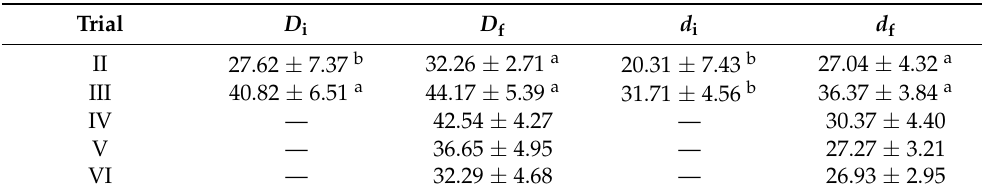
Table 2. Mean ( ± SD) size ( µ m) of larger ( D ) and smaller diameters ( d ) of oocytes from yellow clam ( Amarilladesma mactroides ) at the beginning and the end of the 14-day conditioning period in trials II and III, and at the end of trials IV, V, and VI. Superscripts indicate significant differences between D or d within the same